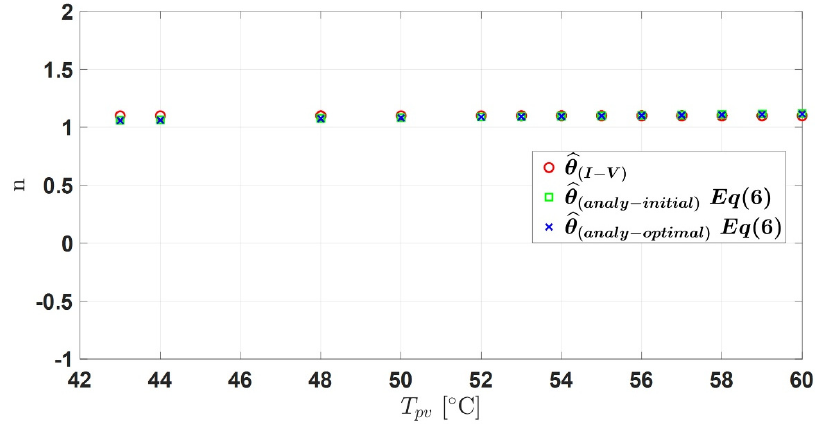
Table 10. Extracted reference value 𝑛 (cid:3045)(cid:3032)(cid:3033) .